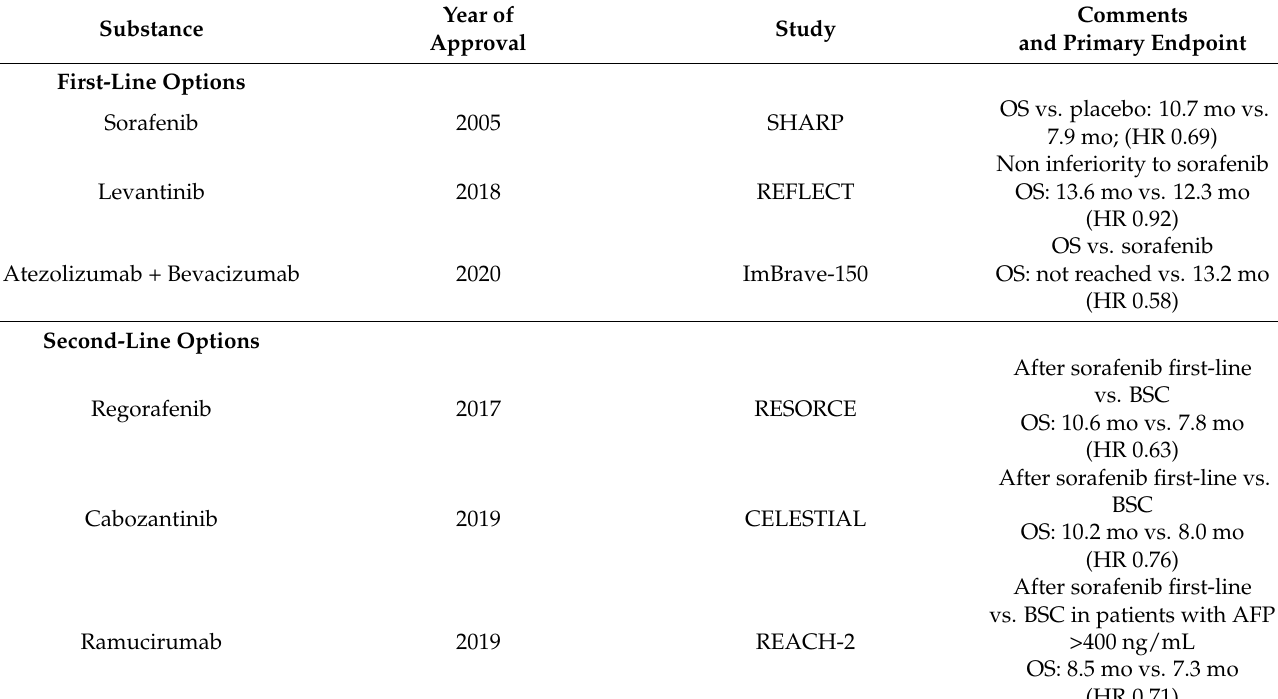
Table 1. Approved substances in the treatment of